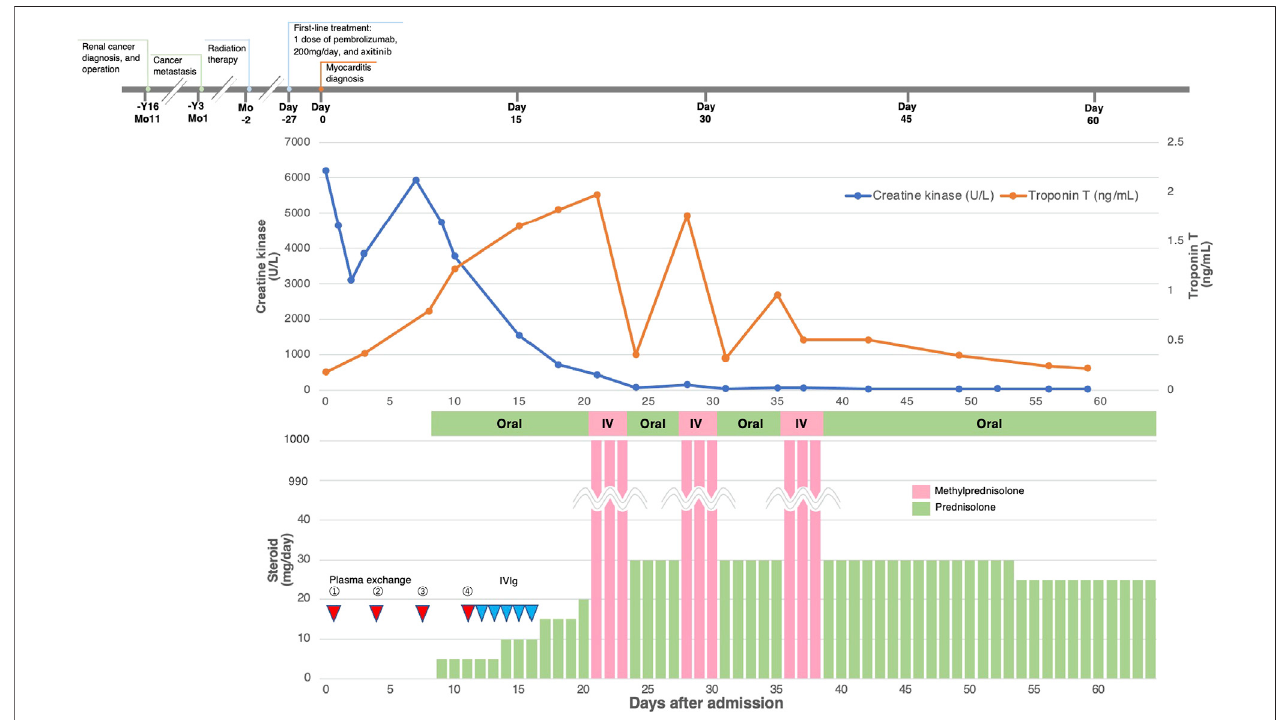
FIGURE 2 | Clinical course and changes in CK and troponin in case